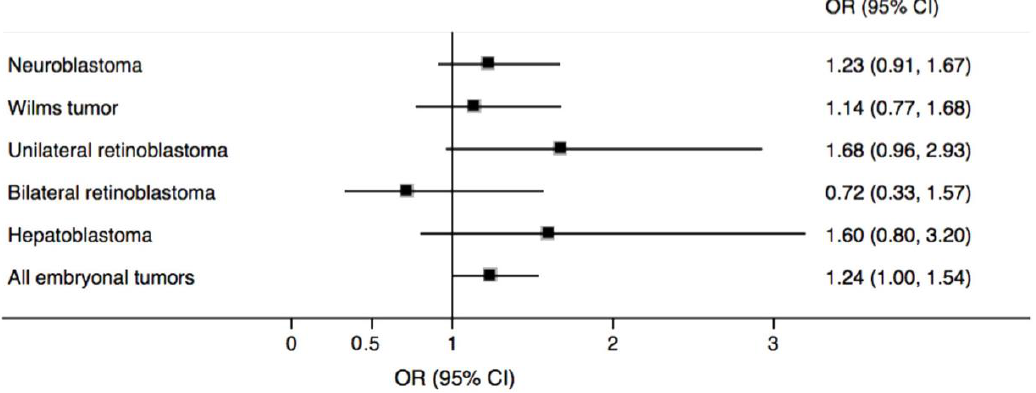
Figure 1. Adjusted odds ratios (OR) and 95% confidence intervals (CI) for maternal residential proximity <500 m from the nearest major roadway and embryonal tumors in offspring. The squares represent the adjusted OR for each tumor type. The horizontal line intersecting each square represents the respective 95% CI.